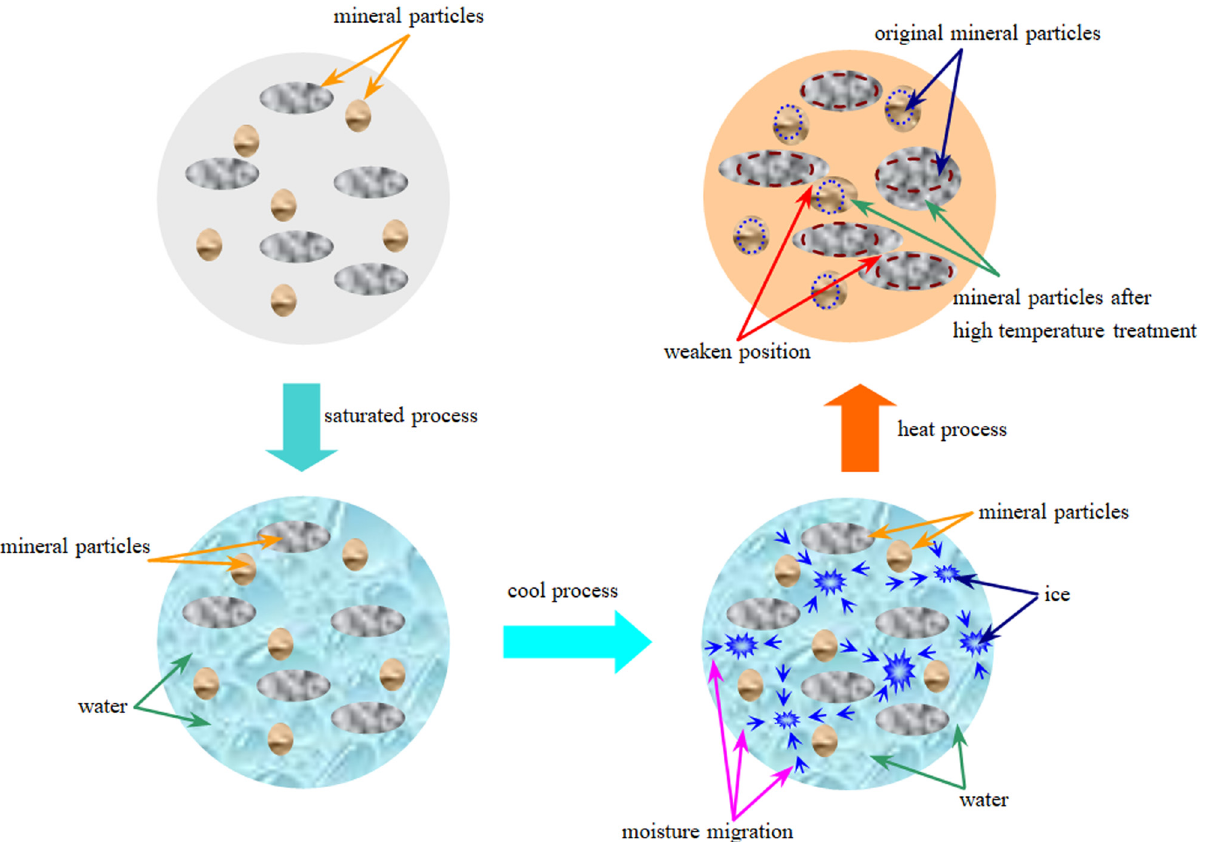
Figure 8: Diagram of thermal damage mechanism in H – C cycle